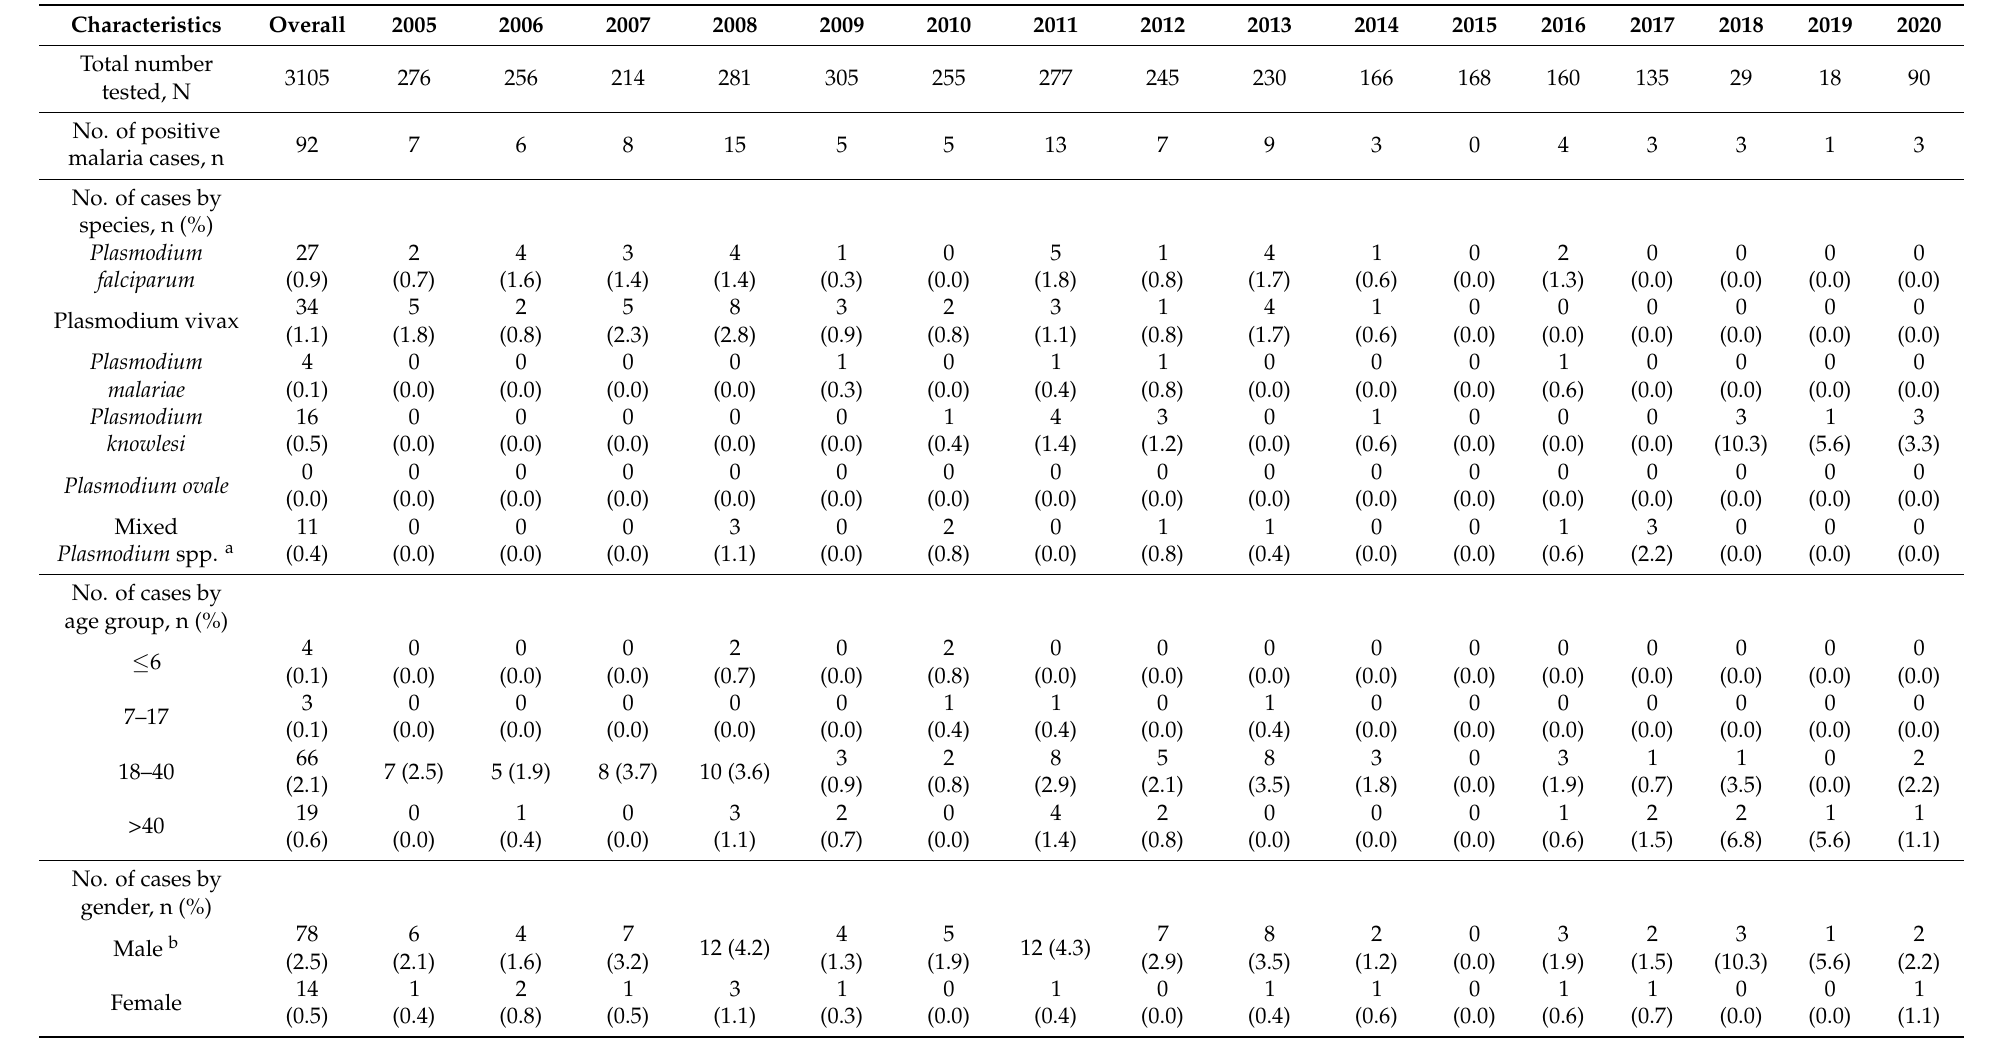
Table 2. Number of malaria cases per year reported at University Hospital of the National University of Malaysia (UKM) in 2005–2020.